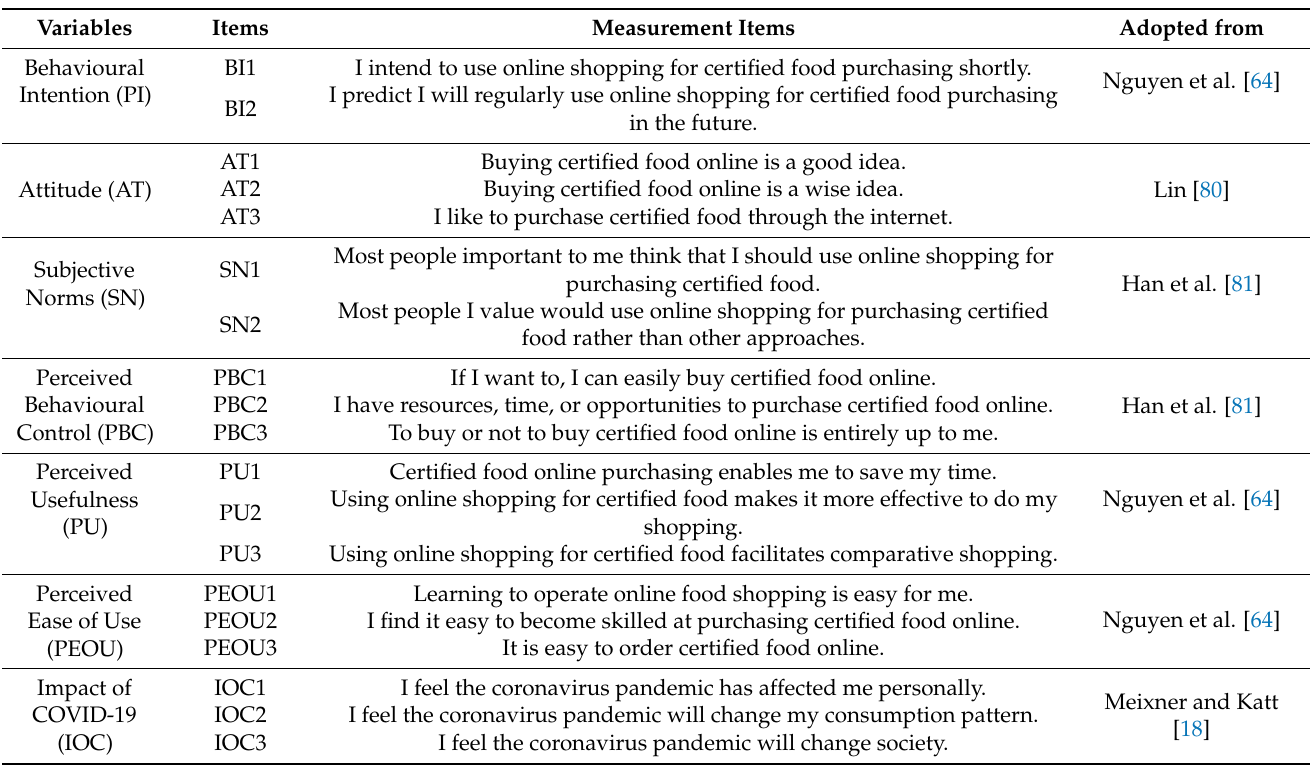
Table 2. Questionnaire items and their source of